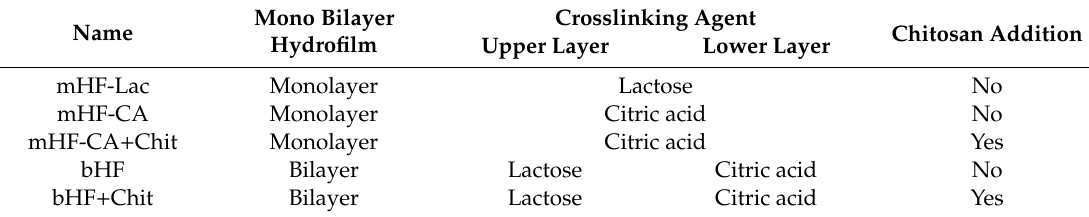
Table 1. Summary of the developed monolayer hydrofilms (mHF) and bilayer hydrofilms (bHF) based on gelatin.